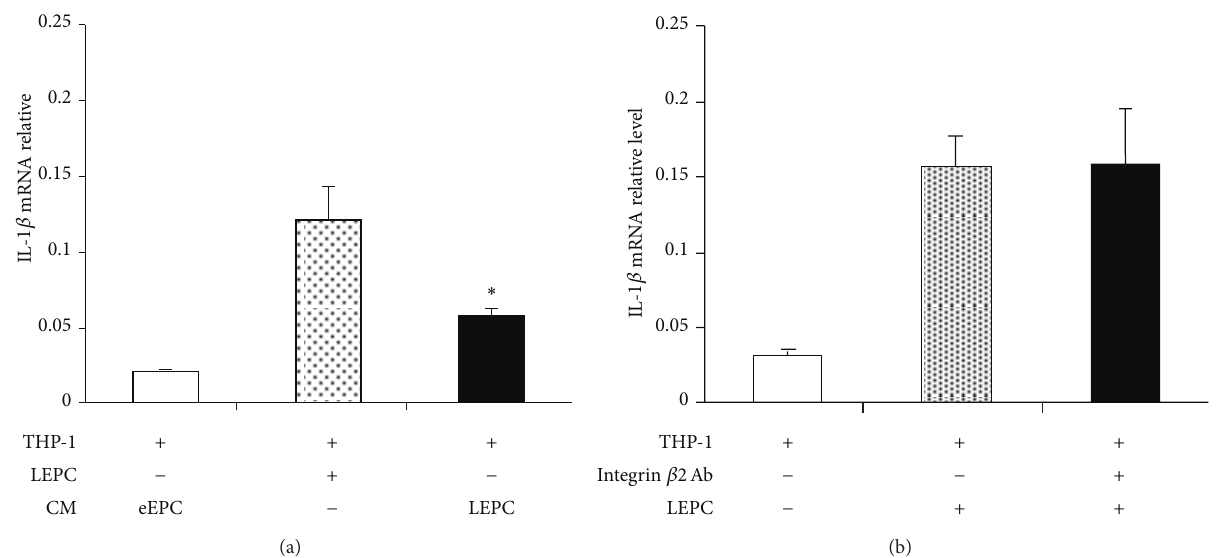
Figure 3: Late human EPCs augmented IL-1 𝛽 expression through a paracrine pathway. THP-1 cells were cultured in the presence of late EPC conditioned medium (CM) with early EPC CM serving as control, and then IL-1 𝛽 mRNA levels in THP-1 cells were determined by real- time RT-PCR. The results showed that late EPC CM was able to partly elevate IL-1 𝛽 mRNA levels (a). THP-1 cells were preincubated with a blocking antibody against integrin 𝛽 2 followed by coculture with late EPCs, which however did not abolish the effect of late EPC stimulated IL-1 𝛽 mRNA increase (b). ∗ 𝑃 < 0.05 ( 𝑛 = 5 ), compared to THP-1 cells treated with early EPC CM. eEPC: early EPC; LEPC: late